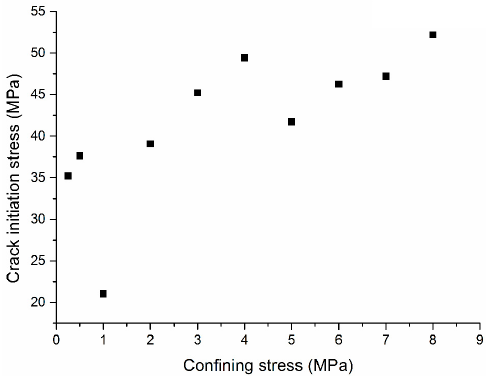
Figure 19. Crack initiation stress for coal specimens of group 1 under different confining stresses.